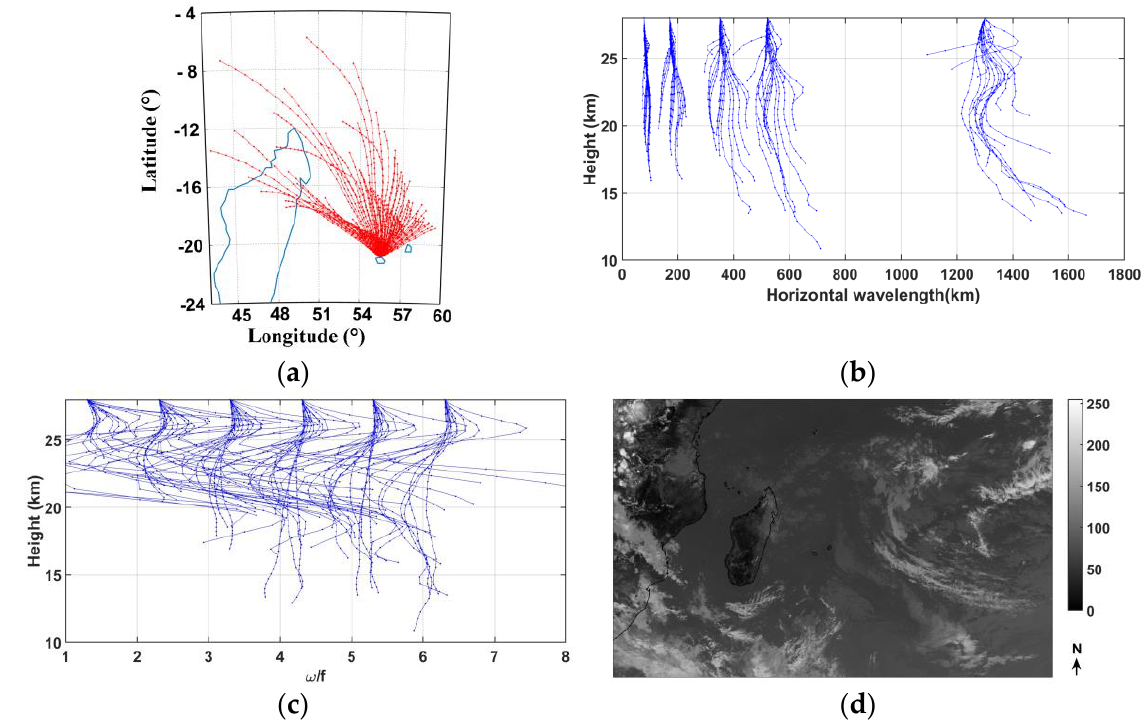
Figure 19. ( a ) Backward trajectories of ~90 individual modes from 9 October 2017 at 1200 UTC using ERA5 data with 37-pressure levels; ( b ) altitude–horizontal distribution; ( c ) altitude– ω /f distribution; and ( d ) Meteosat 8 IR image (gray levels) on 9 October 2017 at 1100 UTC.